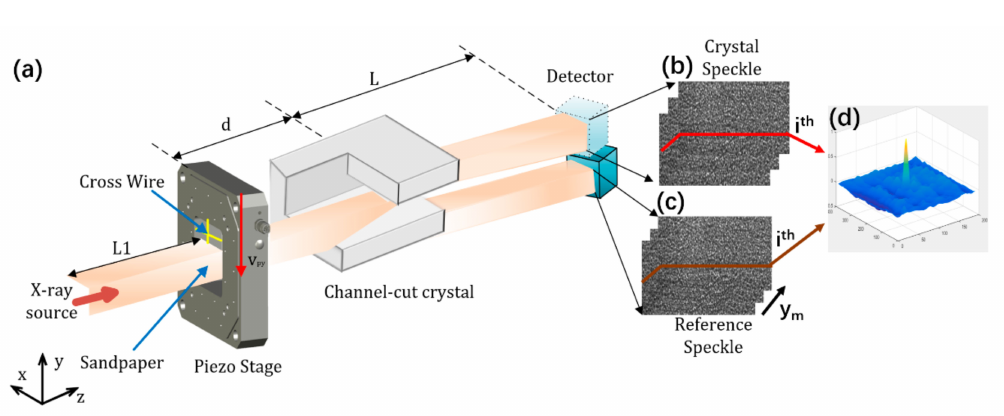
Figure 1. Experimental arrangement and correlation principle for absolute metrology technique. ( a ) Speckle set-up for measuring channel cuts. Stacks of crystal ( b ) and reference ( c ) speckle images retrieved by the detector. ( d ) Cross-correlation map of the two patterns shown in ( b , c